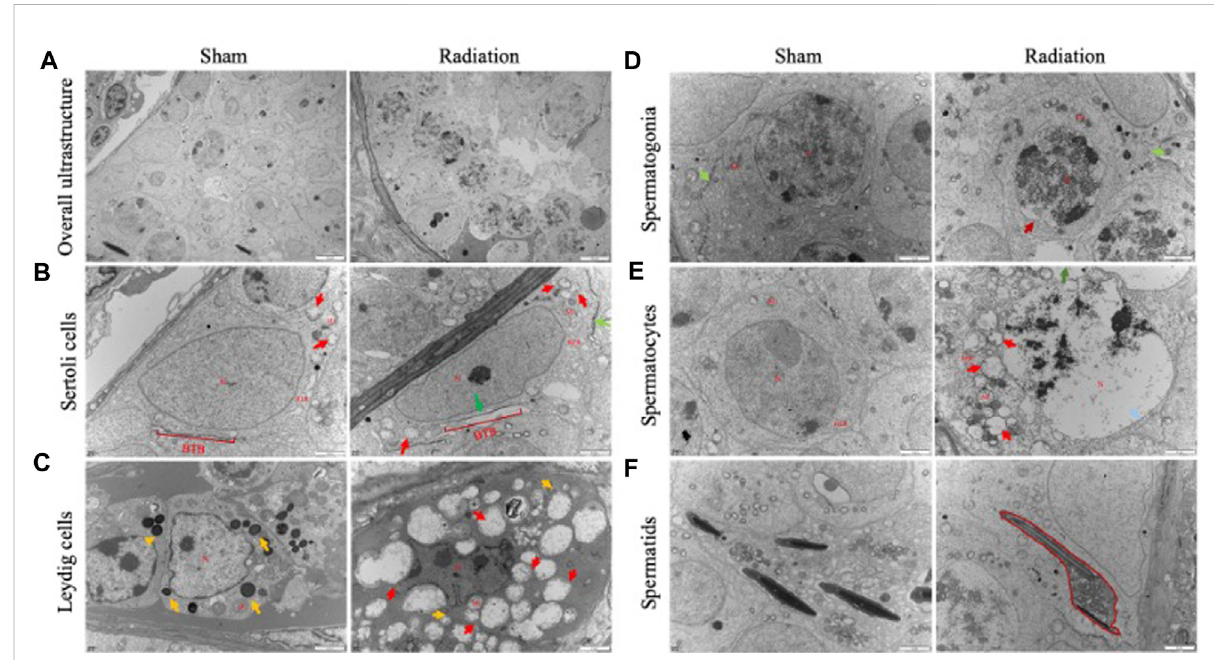
FIGURE 2 AbscopaleffectsofthoracicX-rayirradiationontesticularultrastructureinmice. (A) Overallultrastructureofseminiferoustubules.Bar=10 μ m. (B – F) Ultrastructure of Sertoli cells, Leydig cells, spermatogonia, spermatocytes and spermatids. Bar = 2 μ m, n = 3 for each group. N, nucleus; Mi, mitochondrion; RER, rough endoplasmic reticulum, BTB, blood-testis barrier. Lipid droplets ↑ , Structurally disrupted blood-testis barrier ↑ , mitochondrial swelling ↑ , chromatin dissolution ↑